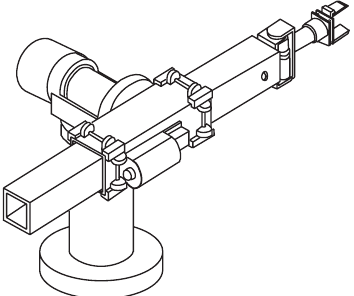
Figure 9. Stanford manipulator.